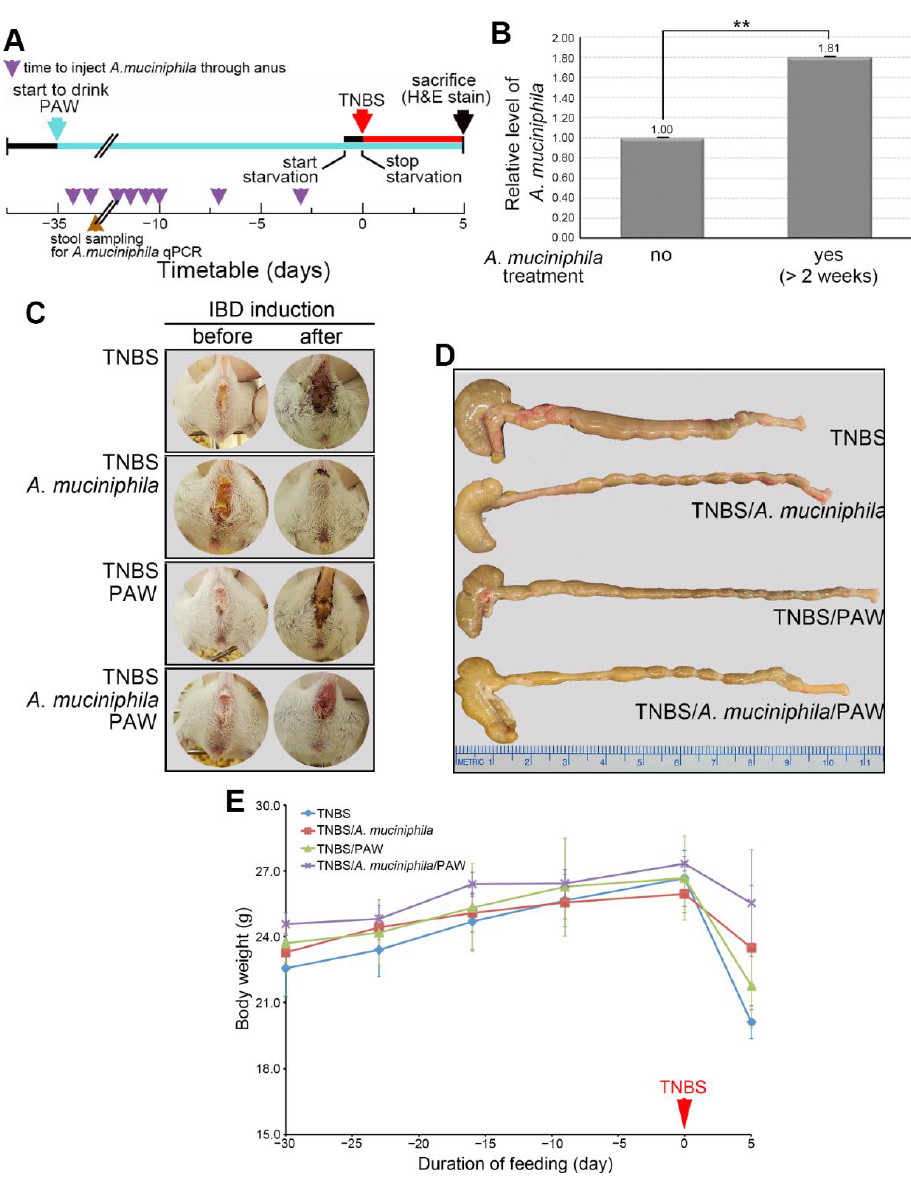
TNF- α (IHC score = 1.5) in colons were detected in the TNBS-treated mice with both PAW consumption and A . muciniphila .